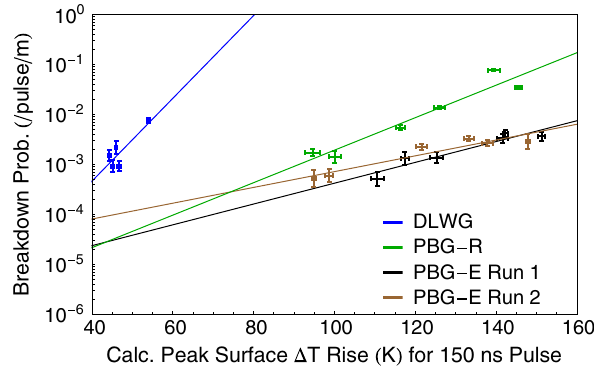
FIG. 20. Breakdown probability per pulse per meter of struc- ture vs peak surface temperature rise for PBG-E, PBG-R, and DLWG structures at a pulse length of 150 ns.